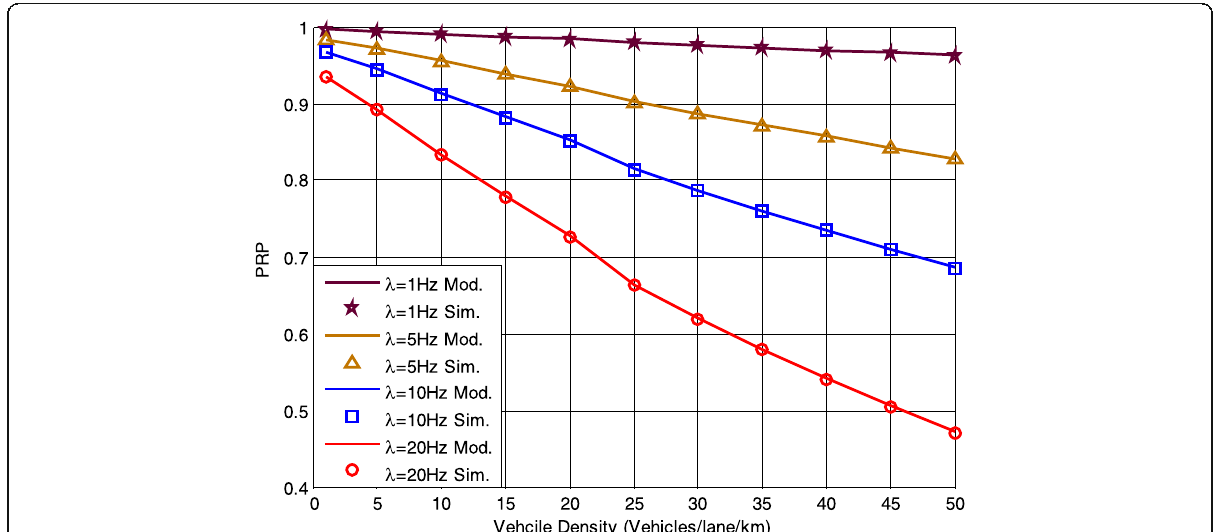
Fig. 14 Comparison of analytic model and simulation results of PRP with hidden terminal collisions for various packet generation rates with respect to vehicle density, W 0 = 16, R = 6 Mbps, R c = 250 m, D = 186